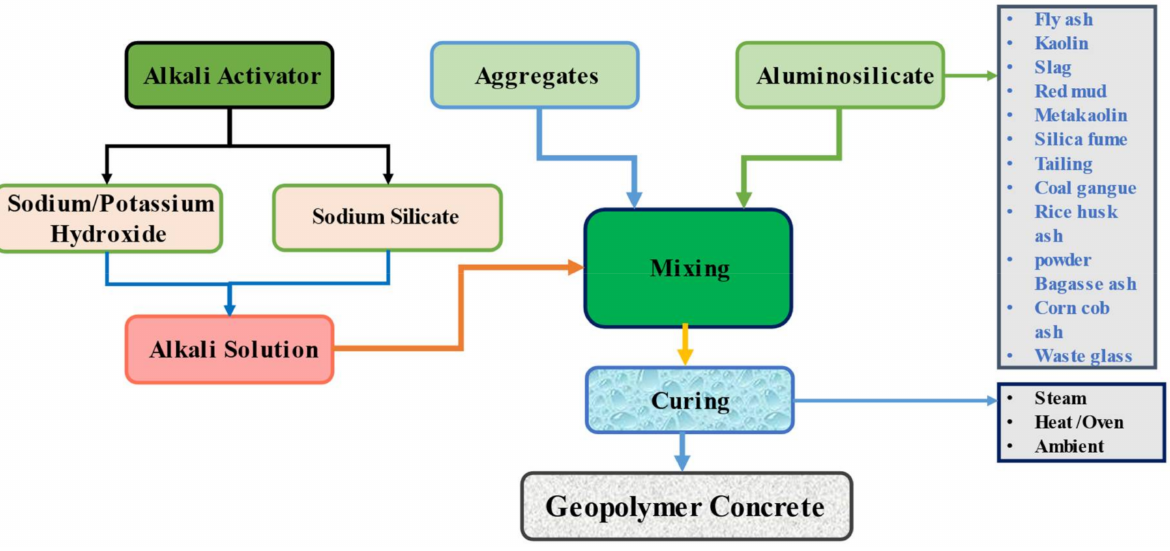
Figure 1. Manufacturing procedure of the geopolymer concrete (Wang, Q., et al.